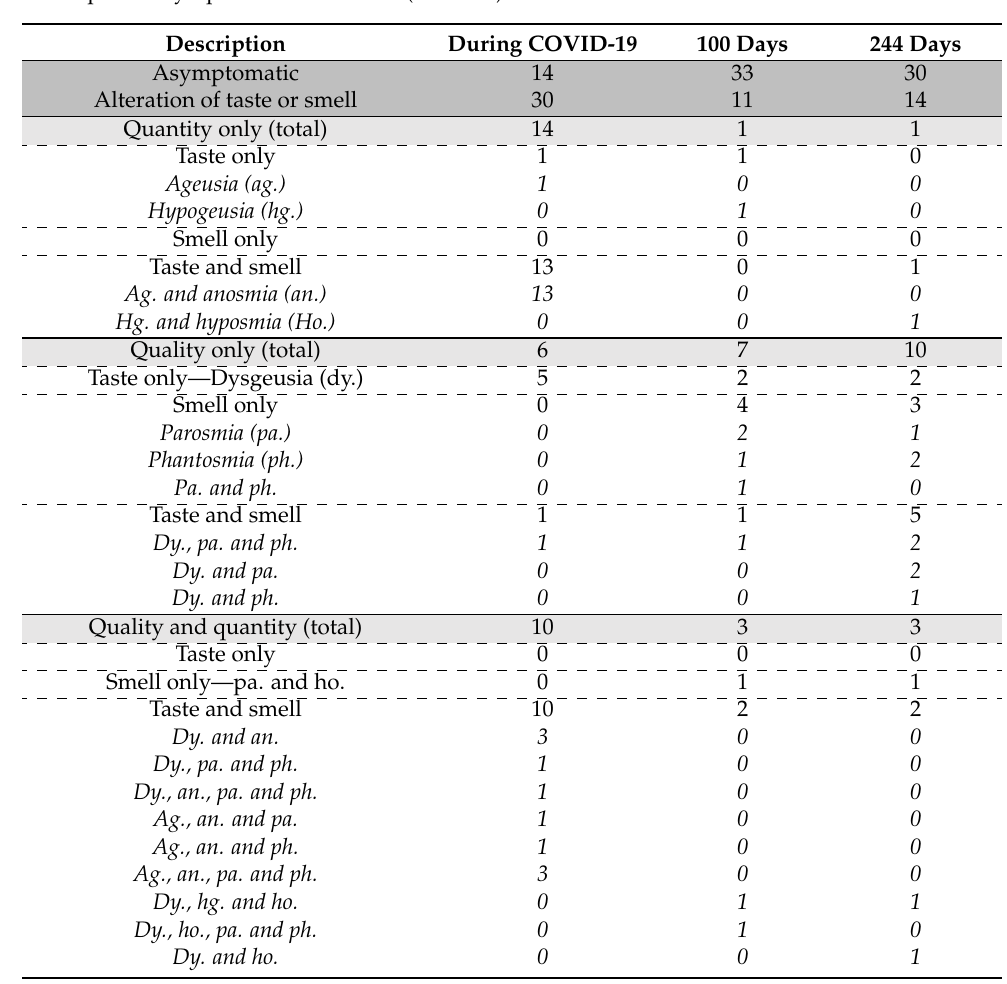
Table A1. Table A1 shows the reported frequencies of qualitative changes (phantosmia, parosmia, and dysgeusia), quantitative changes (anosmia, hyposmia, ageusia, hypogeusia), and which sense was affected during COVID-19 as well as after a median of 100 and 244 days. Data concerning smell and taste during COVID-19 were collected in retrospective. Data concerning timepoint “100 days” was collected by questionnaire Q1, data concerning “244 days” was collected by questionnaire Q2. The two categories “Asymptomatic” and “Alteration of taste or smell” (dark grey background) contain together all 44 study participants. The category “Alteration of taste or smell” is split up in the three groups “Quantity only”, “Quality only” and “Quantity and quality” (light grey background). Each of these three groups is subdivided in “Taste only”, “Smell only” and “Taste and smell” with the respective symptom constellations (in